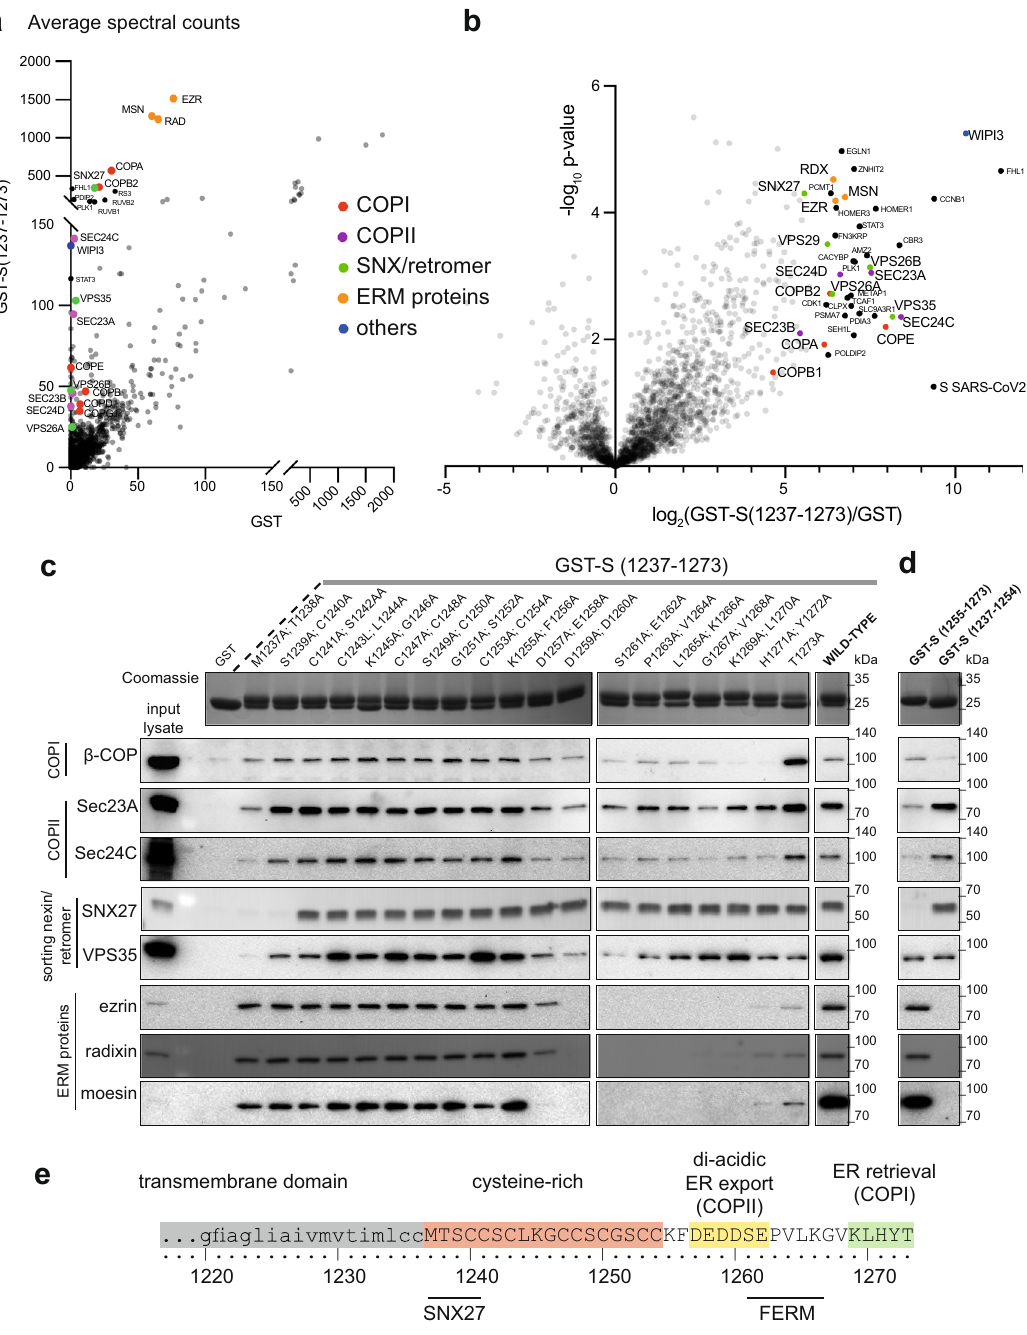
Fig. 1 Proteomic analysis of the binding partners of the cytoplasmic tail of SARS-CoV-2 S protein. a Mass spectrometry analysis from af fi nity chromatography of 293T cell lysates using GST-S tail (1237 – 1273). The plot compares the average spectral counts from three independent replicates of GST-S(1237 – 1273) versus the negative control (GST). Values are in Supplementary Data 1. b Volcano plot comparing the spectral intensities from